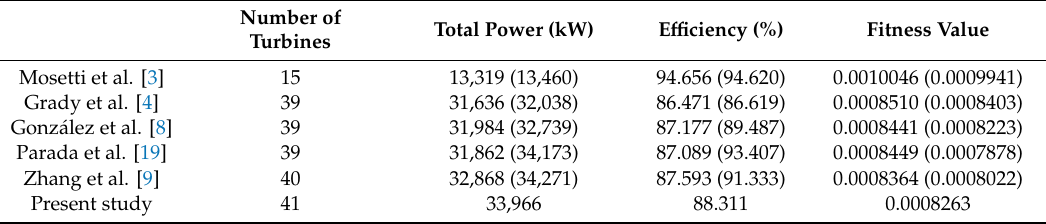
Figure 9. Layout results for case study (c). Table 5. Layout Results for Case Study